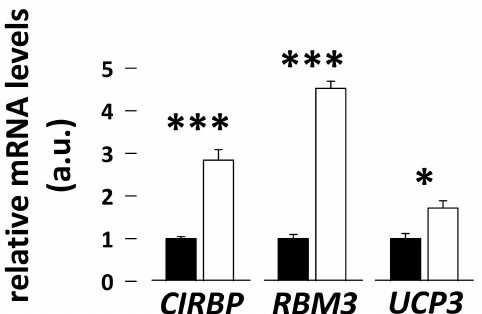
Figure 1. Gene expression of cold-inducible proteins and uncoupling protein 3 (UCP3) in bear skeletal muscle. Levels of cold-inducible RNA-binding protein ( CIRBP ), RNA-binding protein 3 ( RBM3 ), and UCP3 were measured using RT-qPCR in vastus lateralis muscle samples from summer-active (black bars) and hibernating (white bars) brown bears. Data (N = 8 / group) are expressed as means ± sem, with values in the hibernating period being normalized to those in the summer-active condition, which were arbitrarily set to 1. Statistical significance is shown for paired student t -tests (* p < 0.05; *** p < 0.0001). a.u.: arbitrary